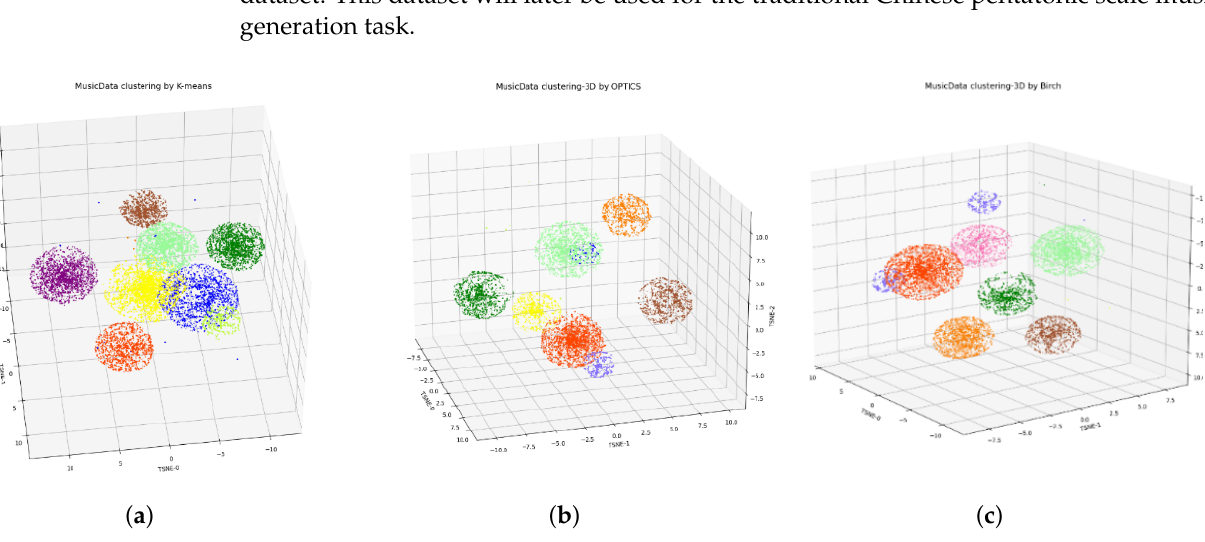
Figure 5. 3D clustering visualization results performed by K-Means ( a ), OPTICS ( b ), and Birch ( c ). The T-Distributed Stochastic Neighbor Embedding (T-SNE) visualization method is applied to the visualization of three